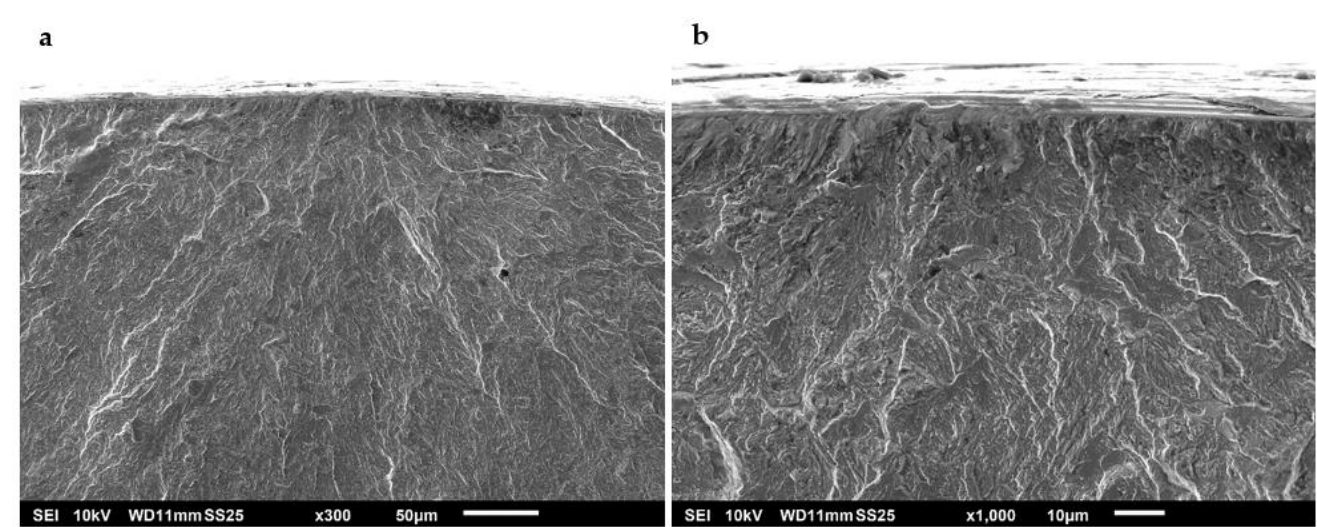
Figure 10. Surface crack initiation of an A-type steel specimen tested in air to a maximum stress of 1070 MPa (75% YS) at ( a ) ×300 and ( b ) ×1000.